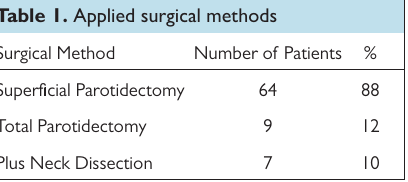
Table 1. Applied surgical methods Surgical Method